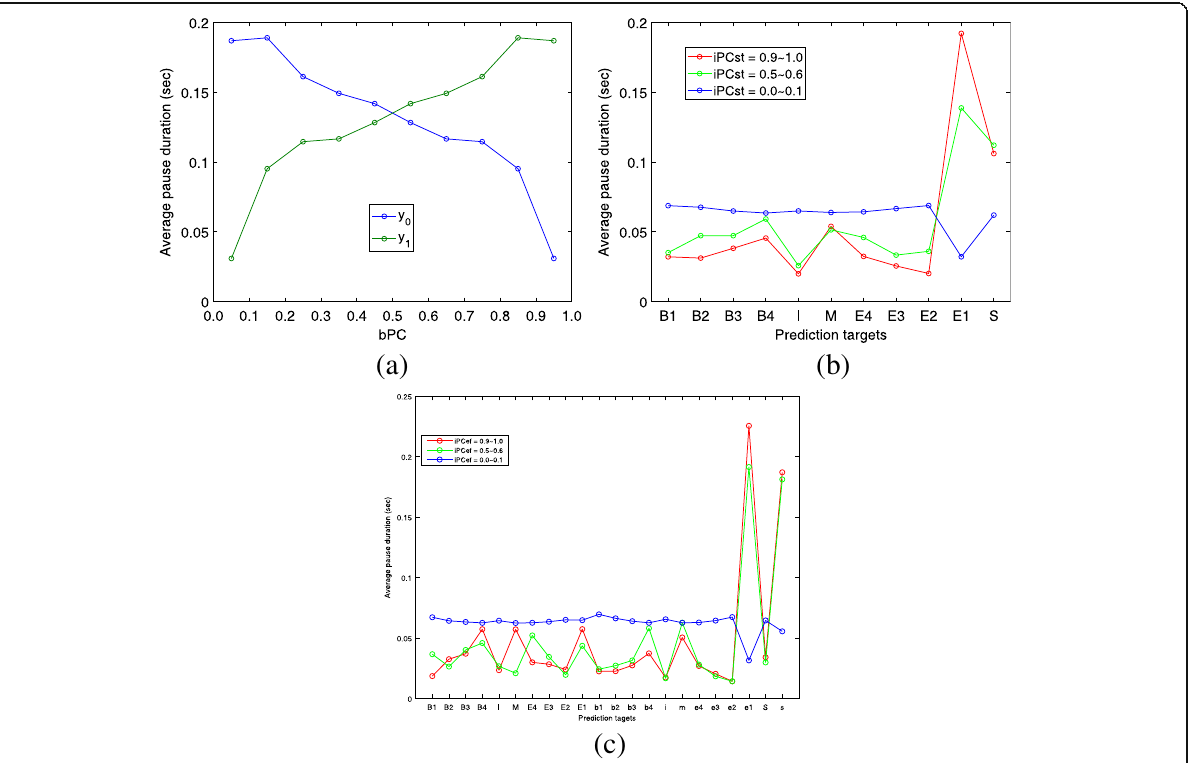
Fig. 7 Average pause durations corresponding to the prediction targets for a bPC, b iPCst, and c iPCef in different levels of PC